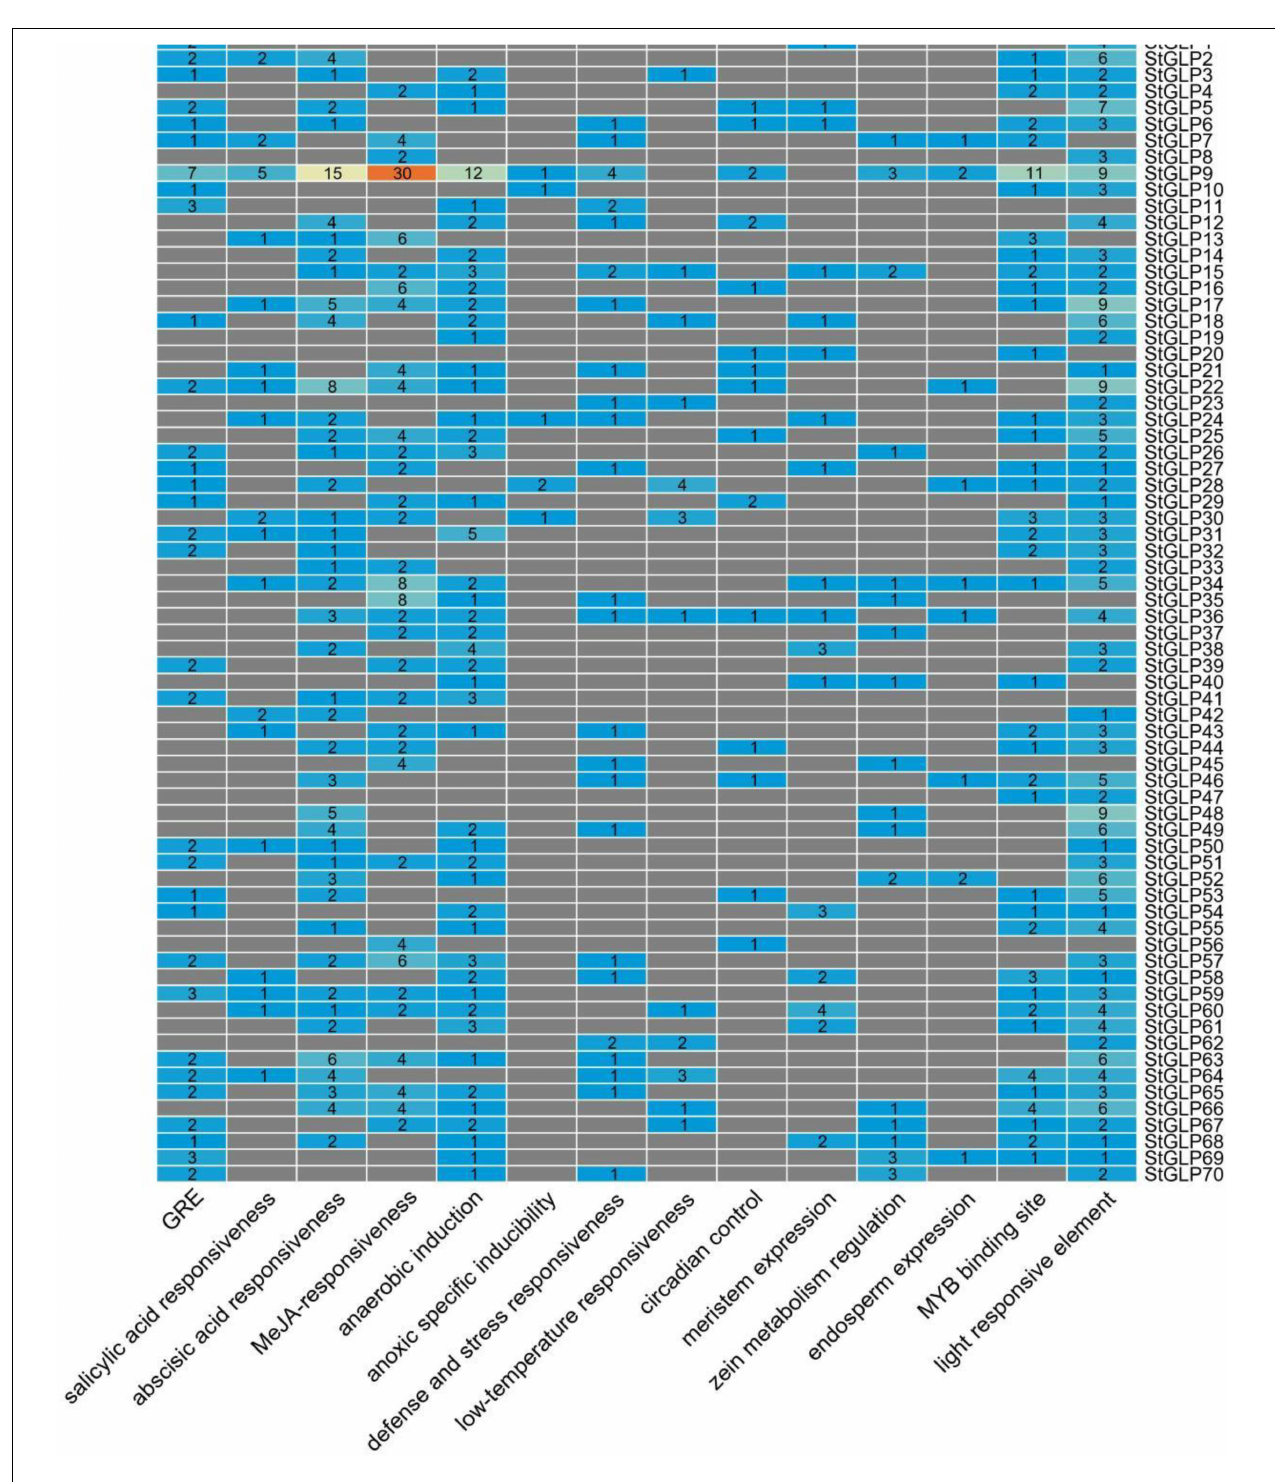
FIGURE 5 | Cis -acting elements distribution in the upstream regulatory regions of StGLPs .